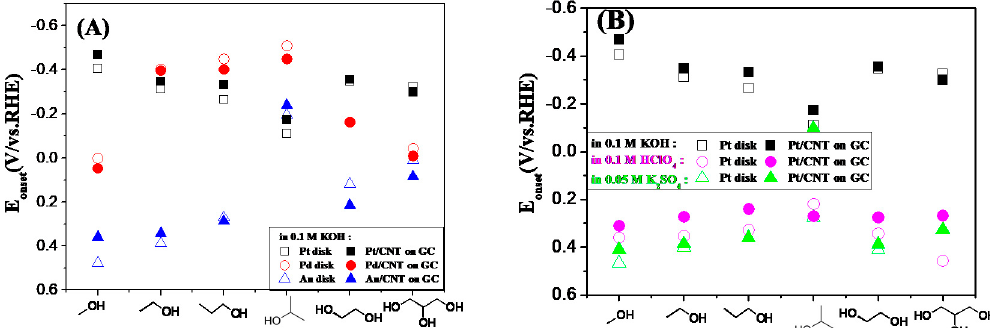
Figure 10. Comparison of the onset potential of electro-oxidation over di ff erent electrodes in 0.1 M KOH solution ( A ) and over a Pt electrode in di ff erent solutions ( B ). Hollow icons are for metal disk electrodes; solid icons are for nanocatalyst covered GC disk electrodes.